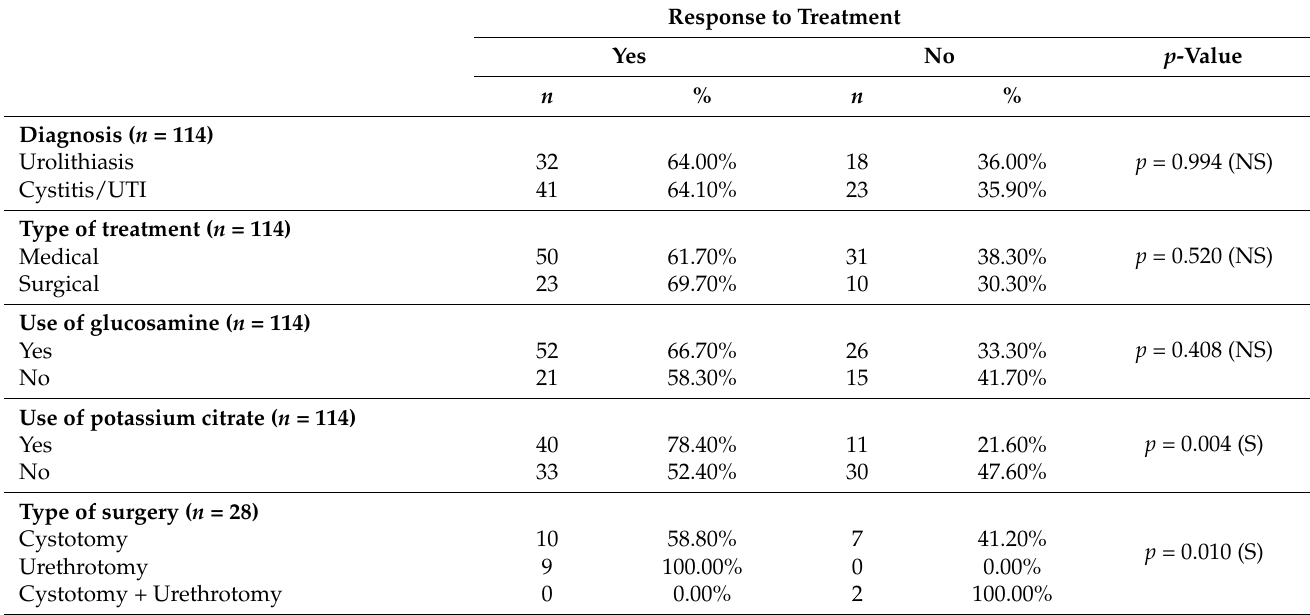
Table 3. Association between diagnosis and therapeutic features with the guinea pigs’ response to treatment in 114 clinical cases diagnosed with lower urinary tract